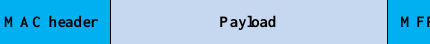
Figure 2. Data packet structure of IEEE 802.15.4. MFR, MAC